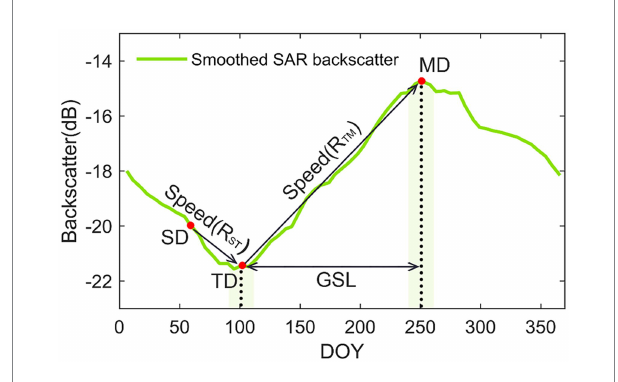
FIGURE 5 An VH backscatter profile of the rice field and schematic diagram of rice phenological